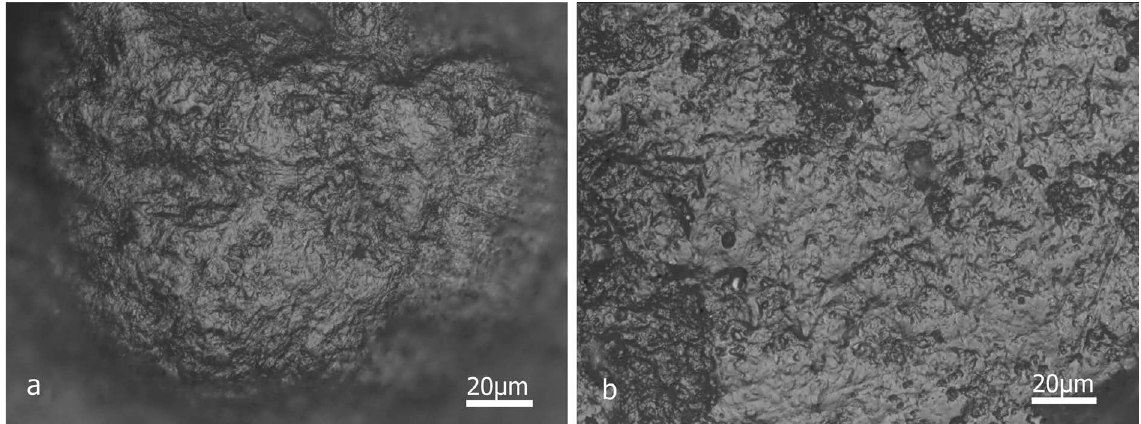
Figure 14. Hide processing polishes on abrading stone as seen with the metallographic microscope; a. experimental traces; b. archaeological traces (photo by I.